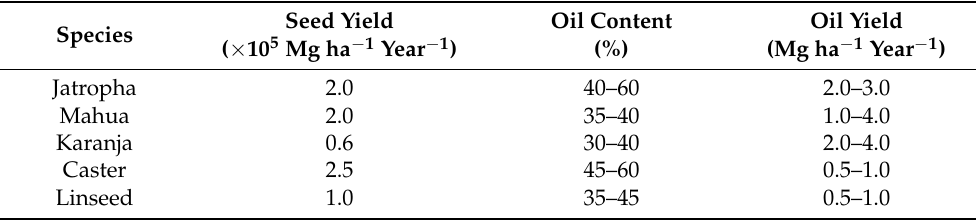
Table 4. Production and oil content of non-edible oilseeds. This information is adapted from Ho et al. [2].